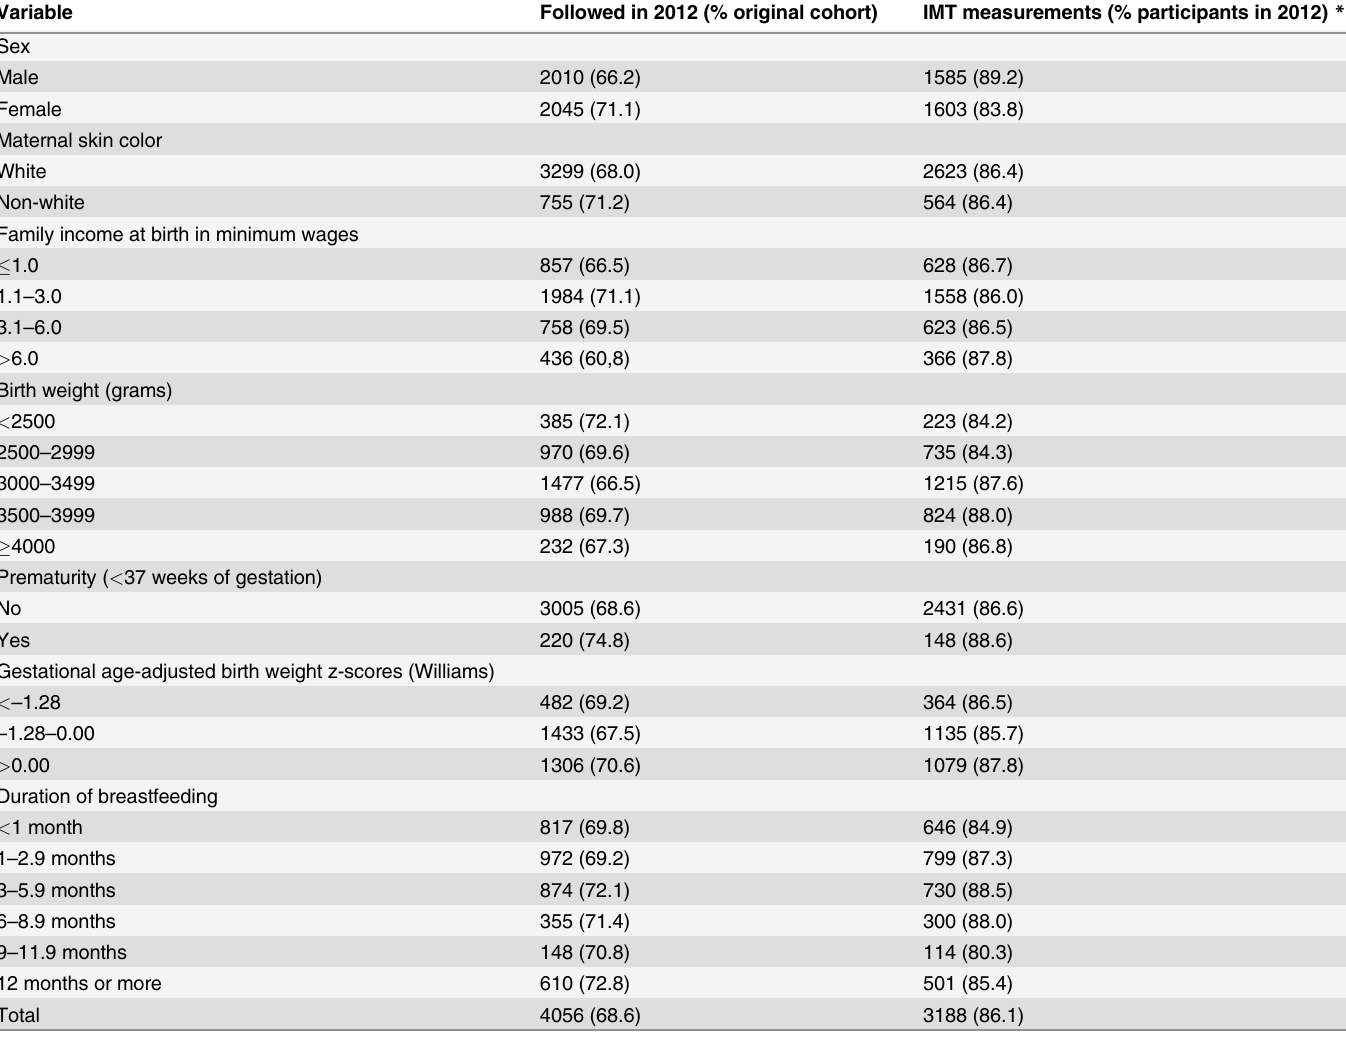
Table 1. Distribution of characteristics, interviews and measurements of carotid intima-media thickness in the original cohort participants at the follow-up in